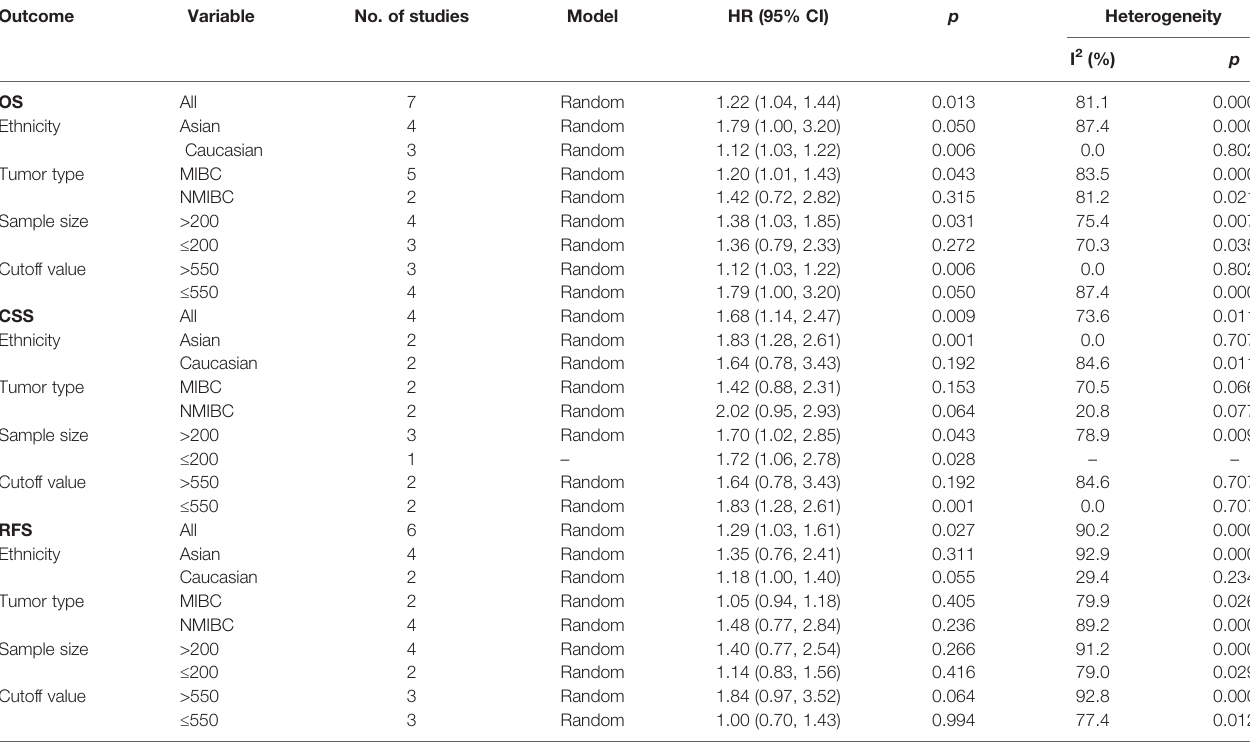
TABLE 2 | Subgroup analyses of OS, CSS, and RFS. Outcome